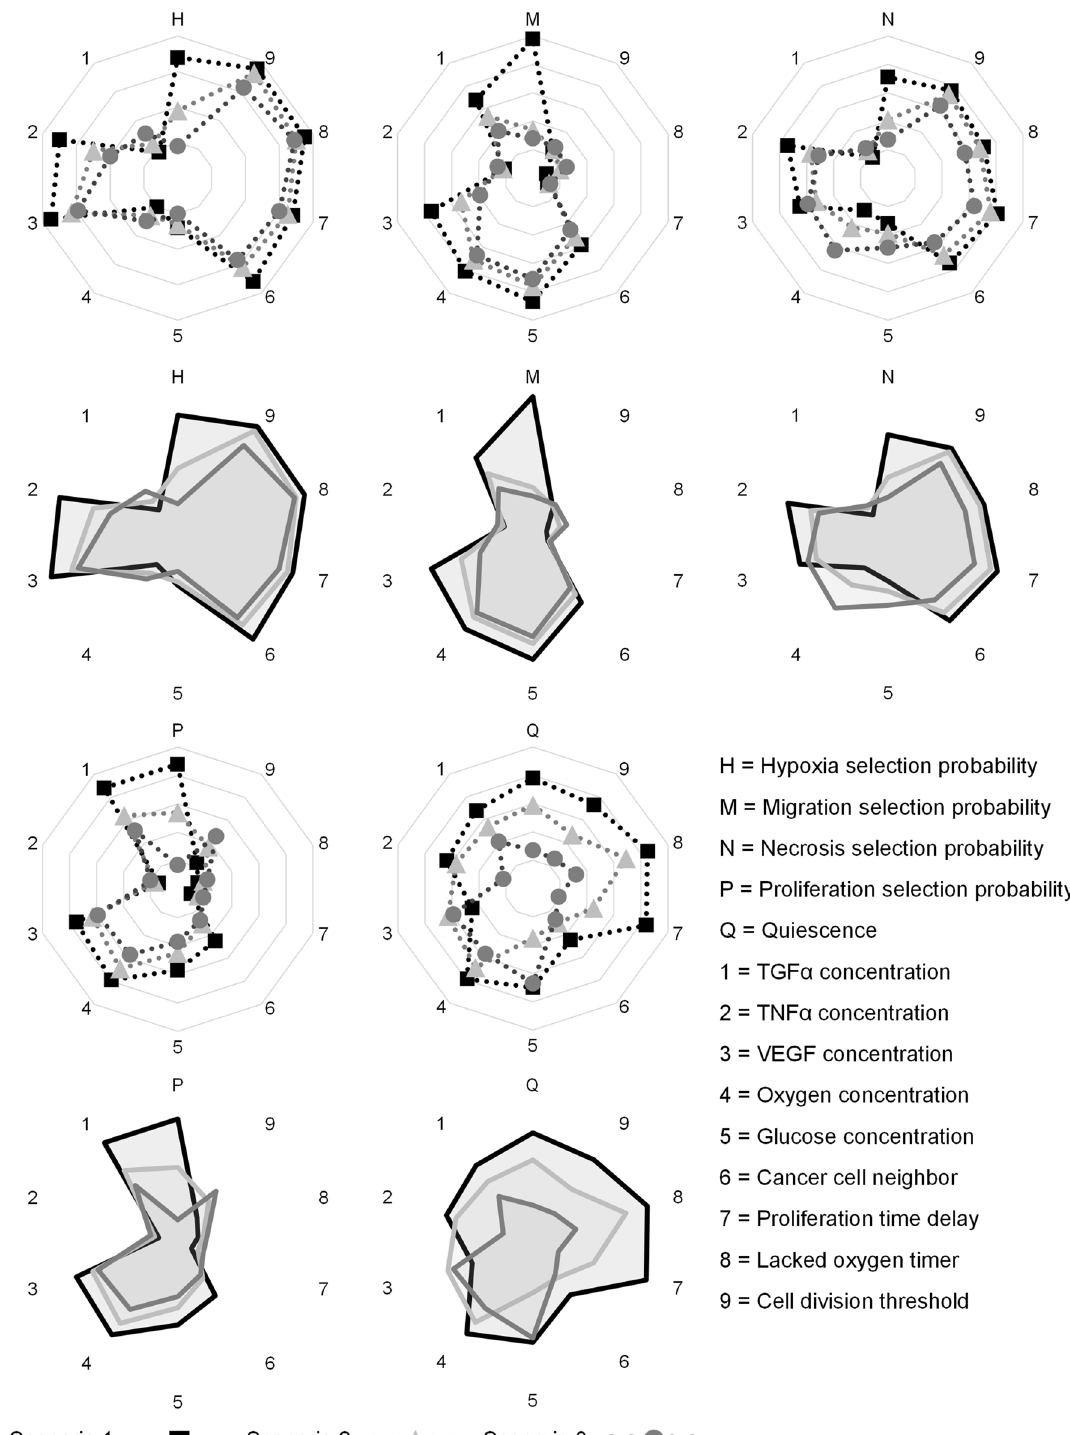
Figure 4. Relationship between phenotype probability selection and model parameters for three different scenarios used during the test phase: (1) phenotype selection probability < 33.3%, (2) 33.3% ≤ phenotype selection probability < 66.6%, (3) phenotype selection probability ≥